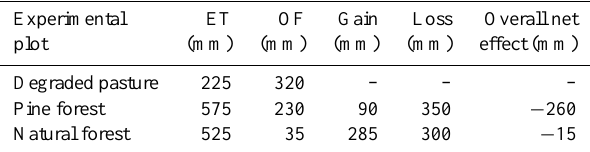
Table 2. Summary of changes in annual ET (mm) and OF(mm), and the resultant gains in infiltration (mm) and evaporative losses (mm) when converting degraded pasture to (heavily used) planted pine forest or (little disturbed) natural broadleaved forest near Dhulikhel, central Nepal. Note that overland flow amounts were calculated for a mean annual site rainfall of 1500mm (Merz, 2004). Note that all values are rounded off to the nearest fifth or